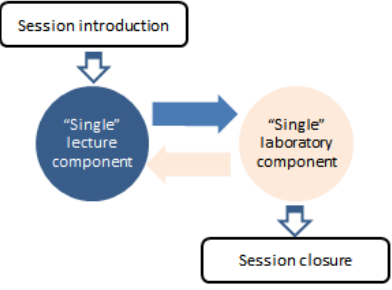
Figure 1. First design model for face-to-face teaching sessions for computing courses extensively using enterprise level systems in their curriculum